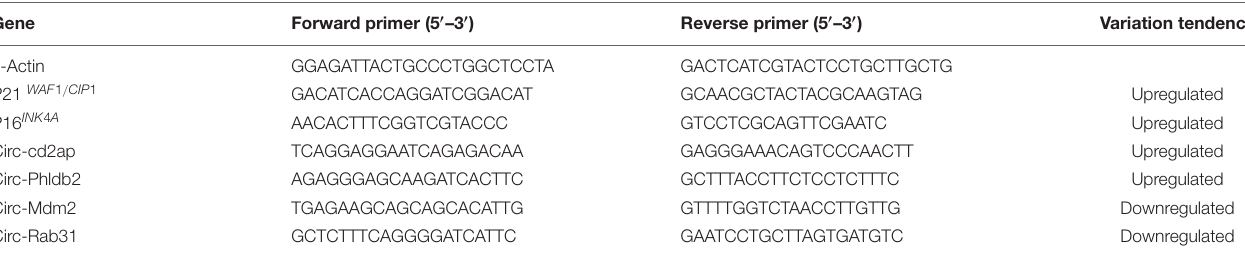
TABLE 1 | Primers used in